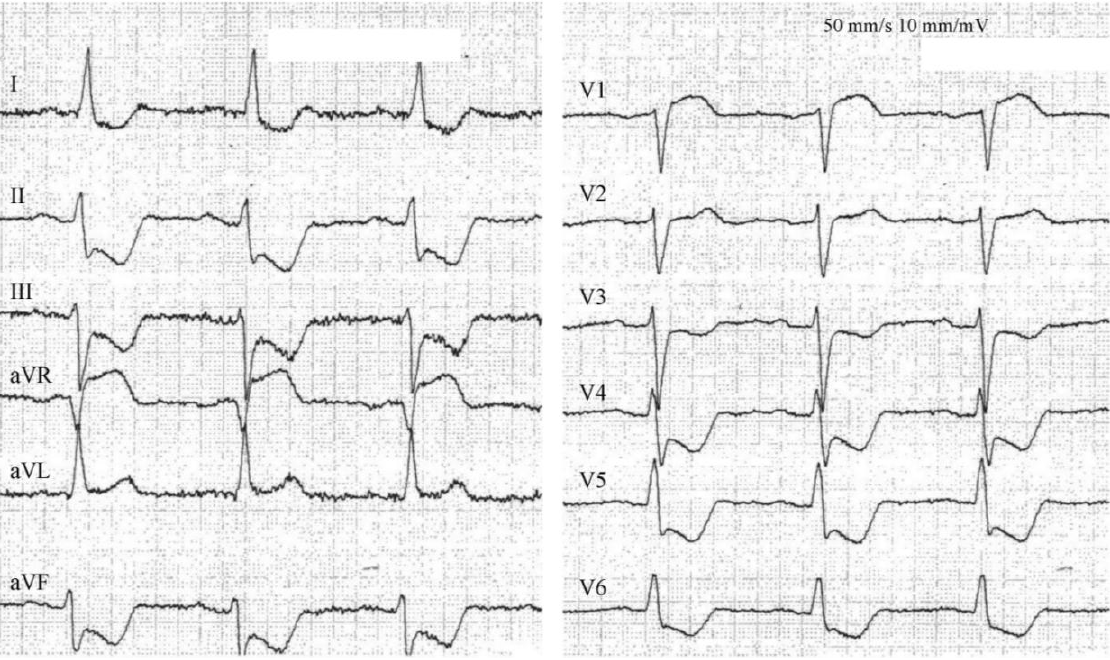
FIGURE 1. 12-Lead ECG reveals a prominent ST-segment elevation in the aVR lead.